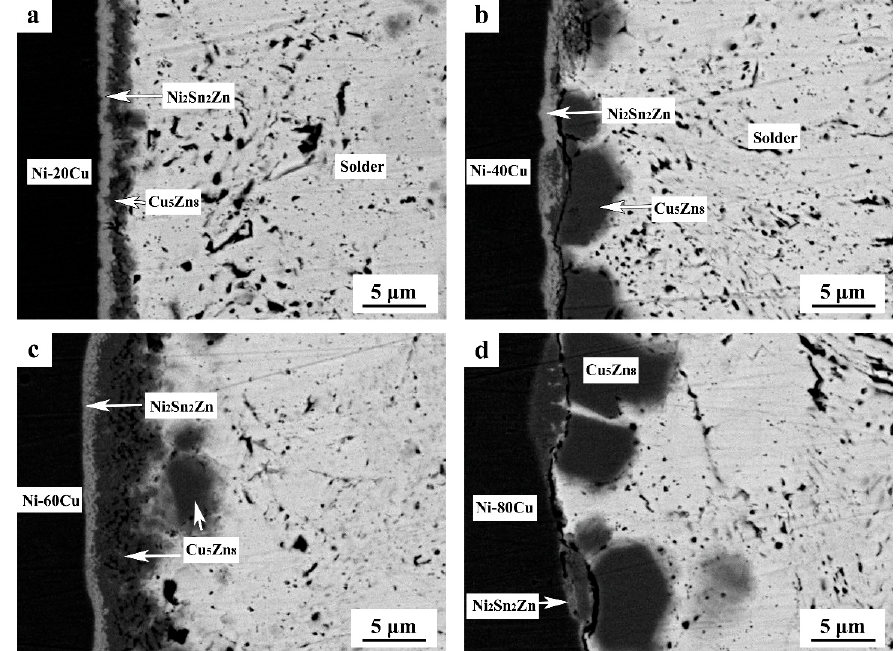
Figure 7. Cross-section micrograph of joints after soldered 2 min at 350 °C: ( a ) Sn-Zn/Ni-20Cu; ( b ) Sn-Zn/Ni-40Cu; ( c ) Sn-Zn/Ni-60Cu; ( d ) Sn-Zn/Ni-80Cu.